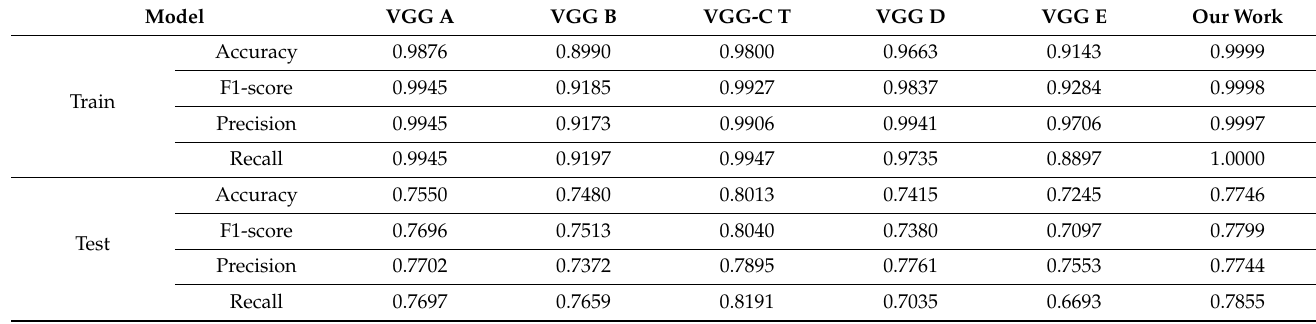
Table 3. Comparison of the result with other